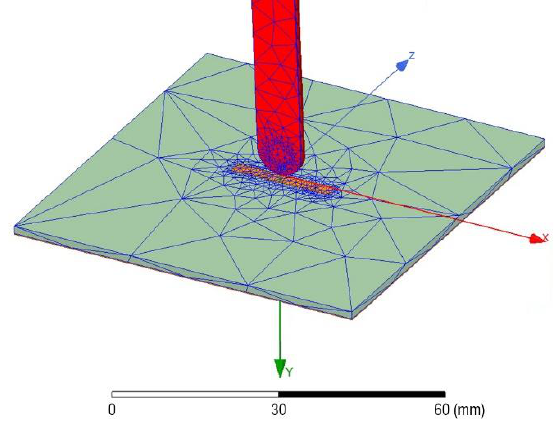
Figure 7. Mesh of the simulation 3D model.